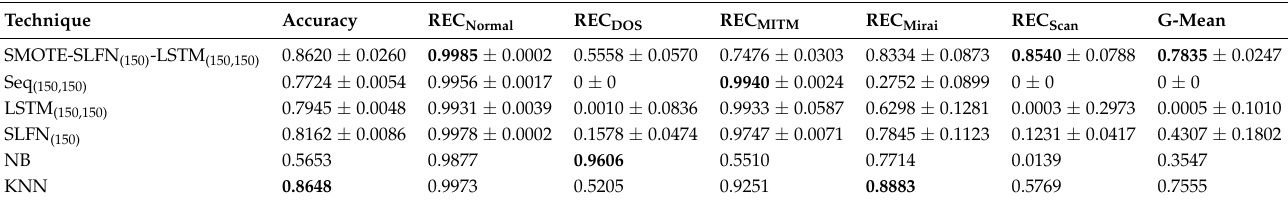
Table 6. Comparative experiments of the proposed approach with other well-known classification techniques. Bold font indicates best